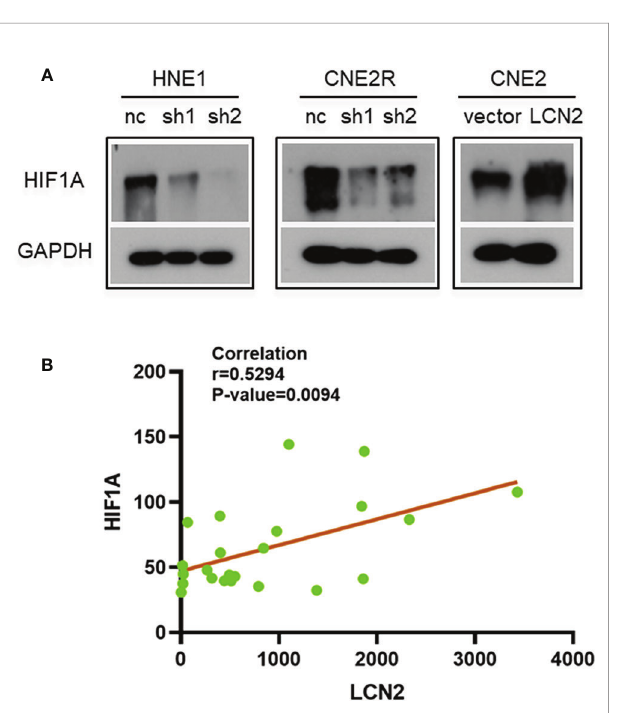
FIGURE 6 | The correlation between the expression of LCN2 and that of hypoxia-inducible factor 1-alpha (HIF-1A). (A) The protein level of the hypoxia- related factor HIF-1A was reduced in both HNE1 and CNE2R cells with LCN2 knockdown, but was increased in CNE2 cells stably overexpressing LCN2. (B) A signi fi cant correlation was detected between LCN2 and HIF-1A expression in 23 NPC tissues using a microarray (Pearson correlation coef fi cient ( r ) = 0.5294, P =